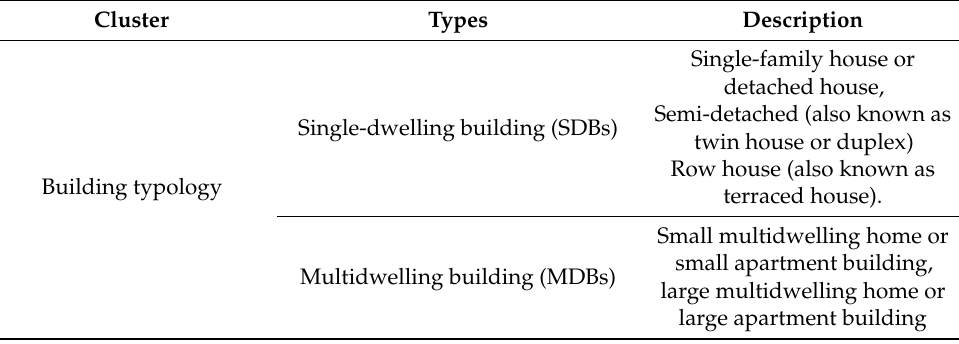
Table 1. Characterization of building typologies and project types: definitions and